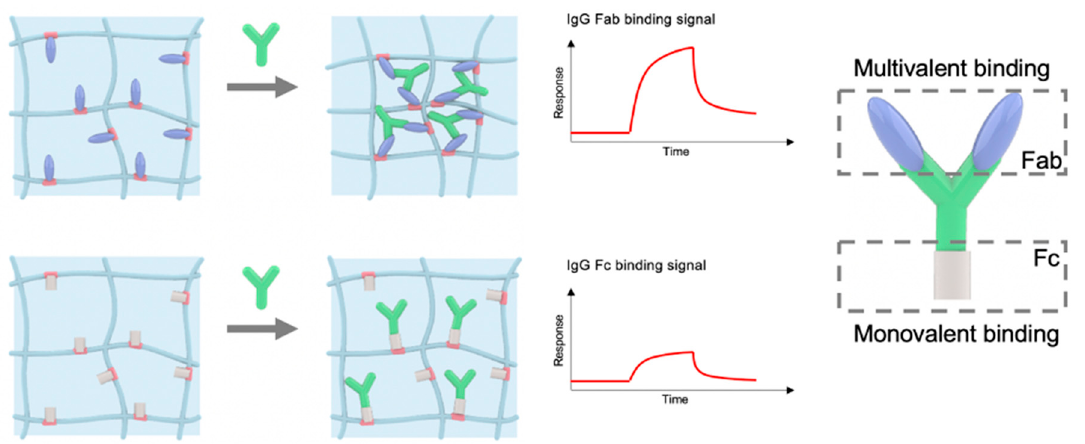
Figure 13. Schematic of an antibody-responsive nanogel and its application for surface plasmon resonance (SPR) analysis.